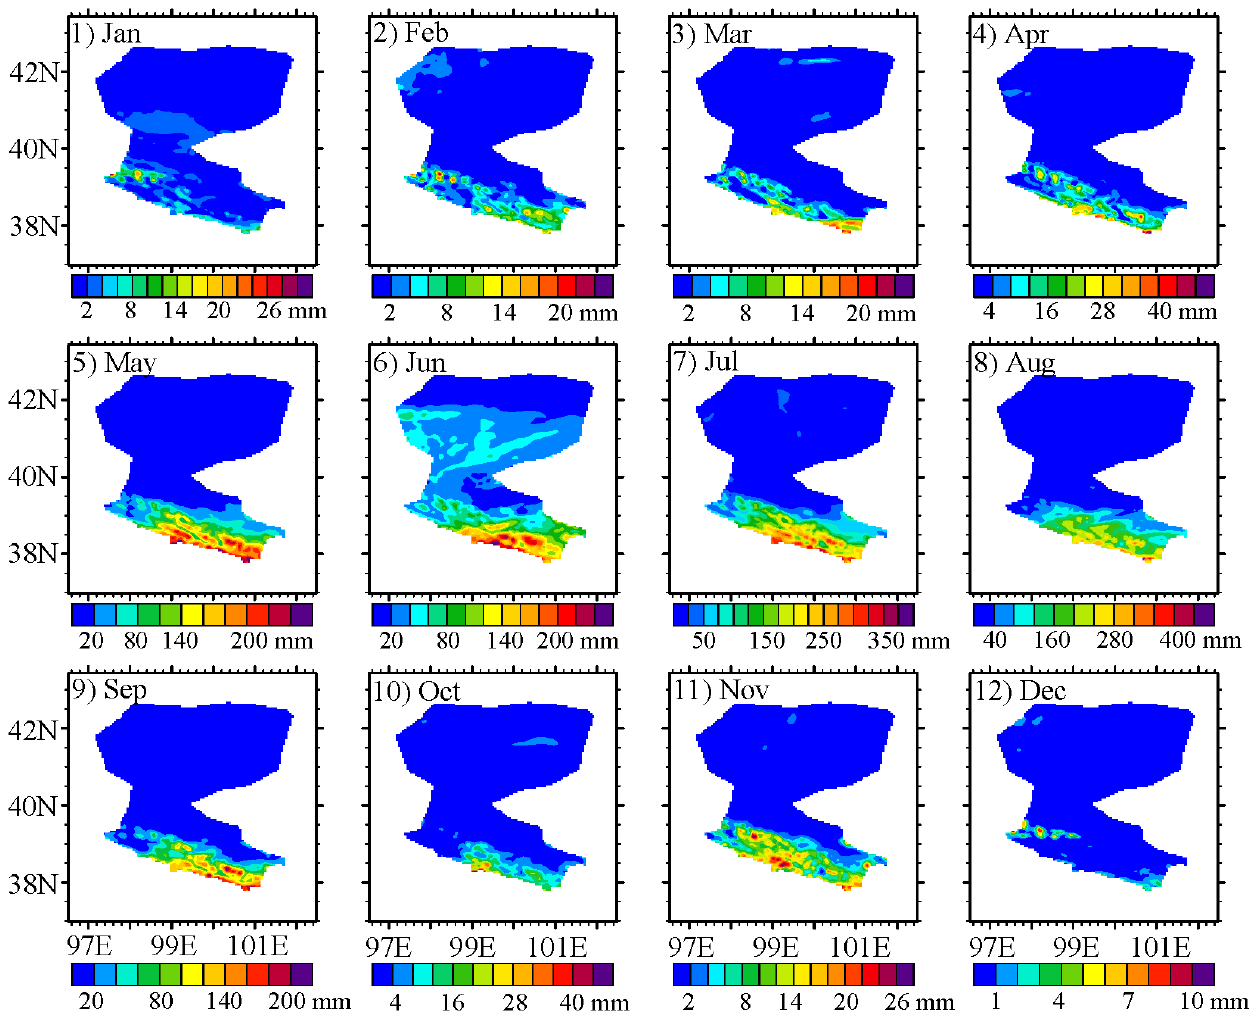
Figure 9. Mean monthly precipitation over the HRB from 2000 to